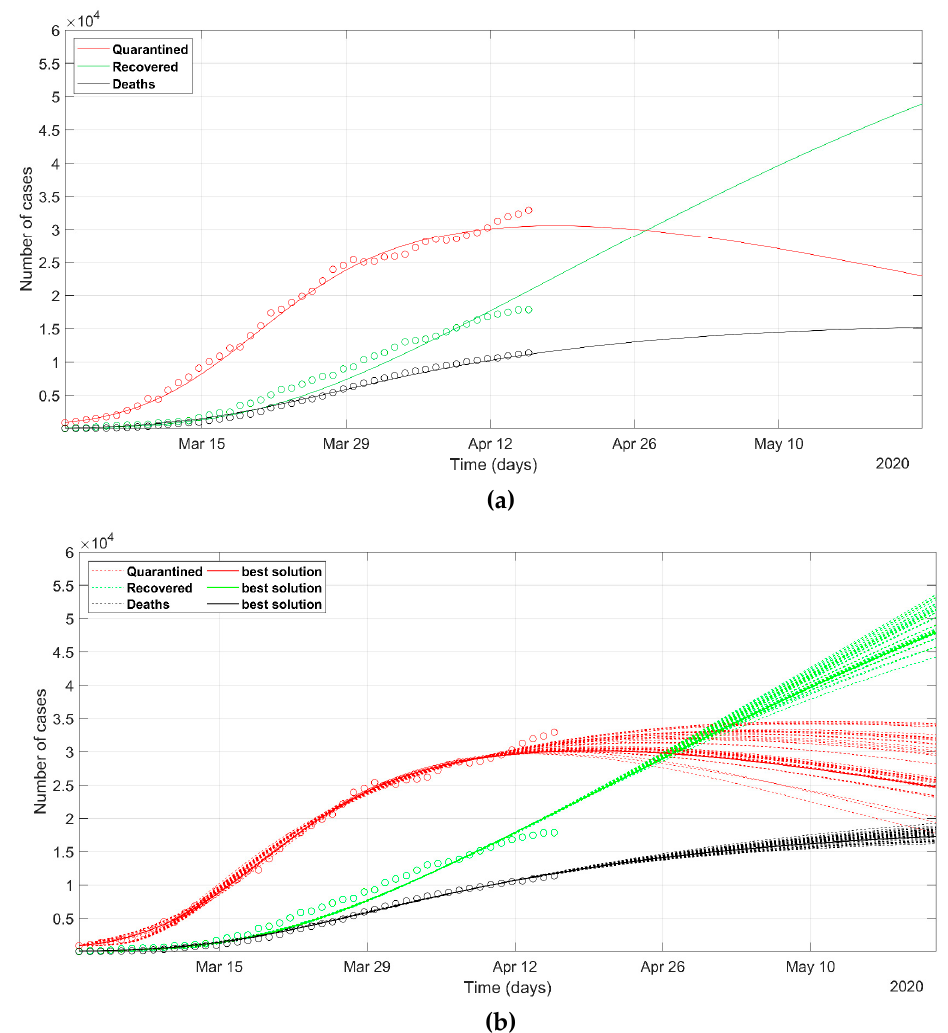
Figure 4. Observed data ( circles ) of quarantined ( red ), recovered ( green ), and deaths ( black ) for the Lombardy region, updated on 15 April 2020. The continuous lines refer to the predicted evolution in 30 days according to the SEIR model solved with ( a ) deterministic approach, ( b ) stochastic approach. In ( b ) the solid line refers to the best PSO solution, the dashed lines refer to the most probable solutions (i.e., the solutions within 5% of the minimum